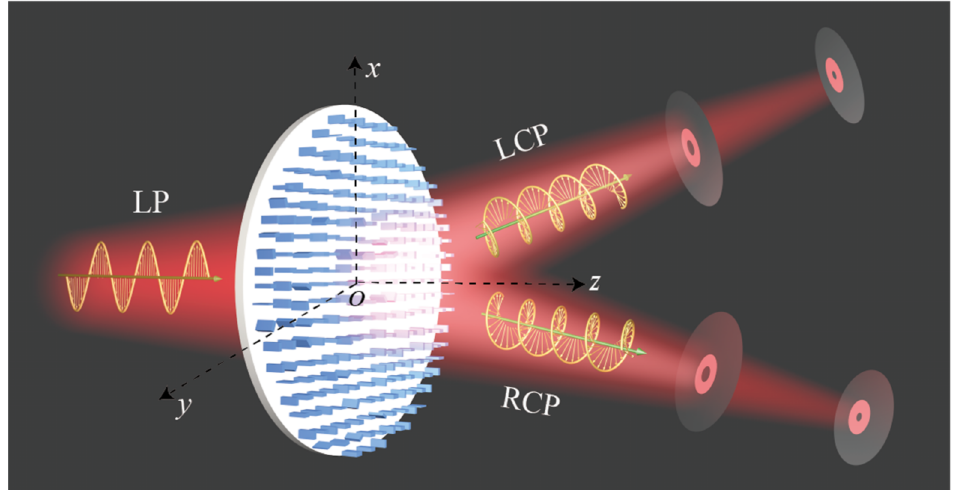
Figure 1. Schematic diagram of multidimensional focused vortex beams generated based on the dielectric spin-multiplexed